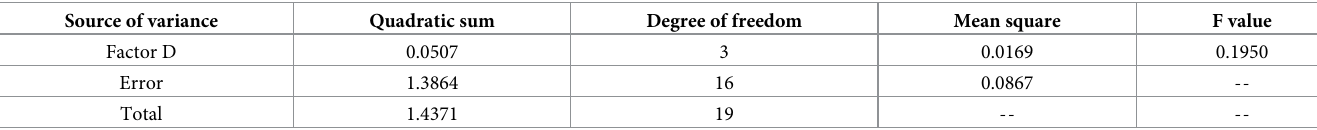
Table 5. Variance Analysis of separation force between black fungus and the sticks with different moisture content. Source of